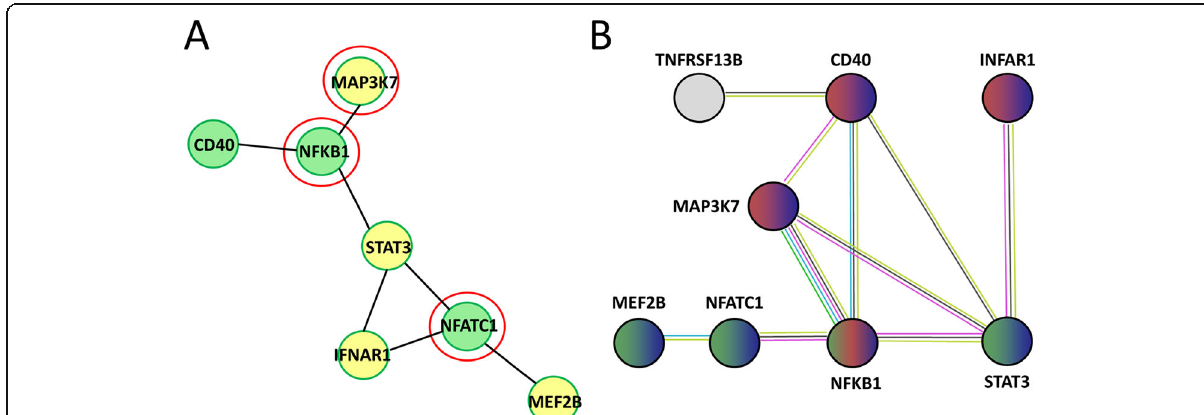
Fig. 7 Biological involvement of the genomic loci dysregulated in DLBCL. Developed using the top 10 EpiSwitch markers identified in this study, the three functional network analyses reveal the involvement of A. Reactome Functional Interaction Network. The nodes marked with red circles are loci in the DLBCL-CCS involved with B-Cell receptor signalling and highlight the involvement of the NF-kB and STAT3 signalling in DLBCL. B. STRING DB Network. A protein-protein interaction network also revealing the involvement of the NF-kB and STAT3 signalling in